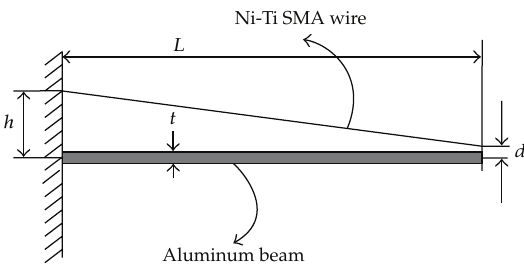
Figure 12: General structure of experimental apparatus.